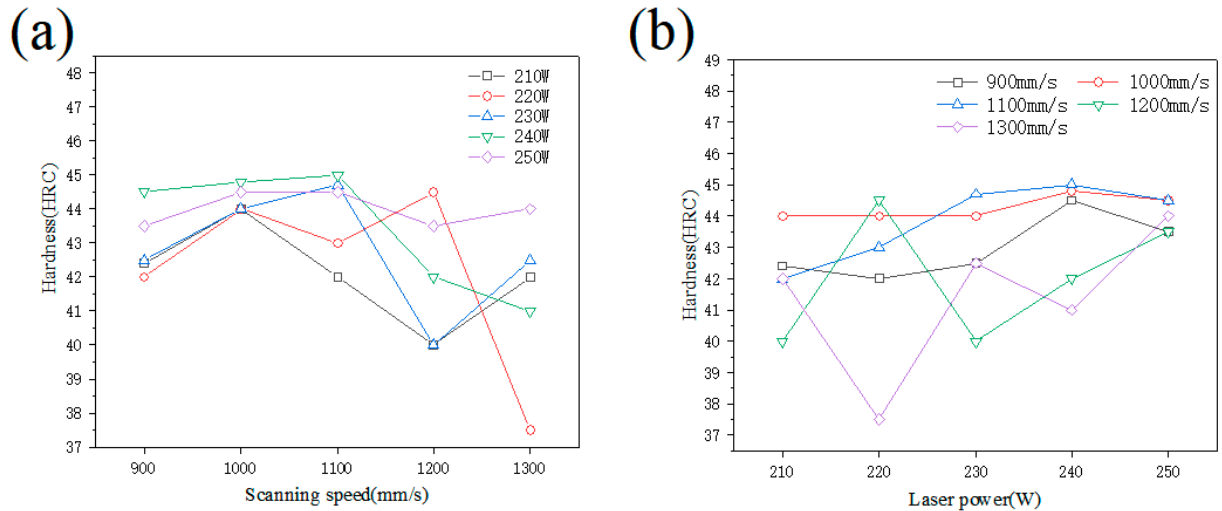
Figure 4. Variation of sample hardness with ( a ) scanning speed and ( b ) laser power.